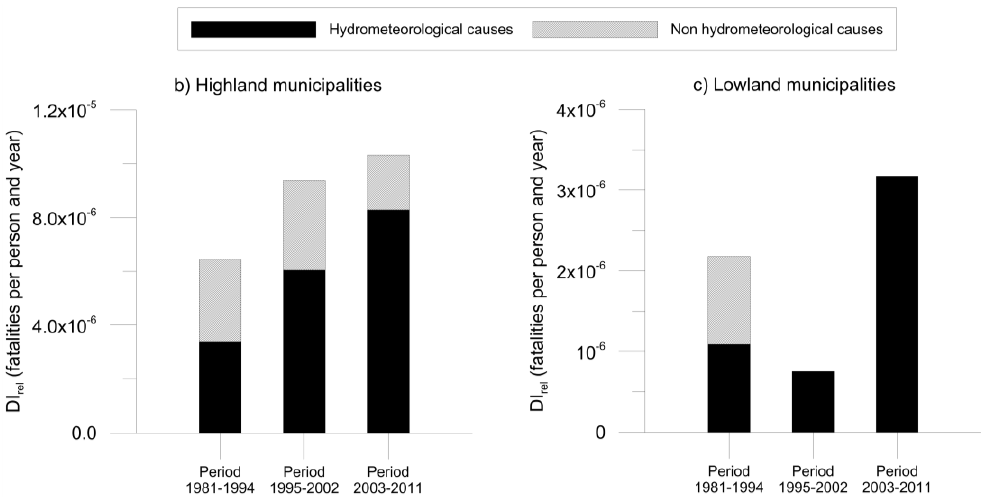
Figure 3. Relative impact of disasters over time. The relative impact of disasters (DI Rel ) is measured by the number of fatalities caused by all the disasters (classified by hydrometeorological and non hydrometeorological causes) during each period, divided by the number of years in the period and the yearly average population in that period ( a ) in the Samala River catchment, ( b ) in the highlands and ( c ) in the lowlands of the catchment. The fatalities resulting from non hydrometeorological causes for disasters correspond to earthquakes and have been included in the graph to show the importance of the hydrometeorological causes in the occurrences of disasters in the case